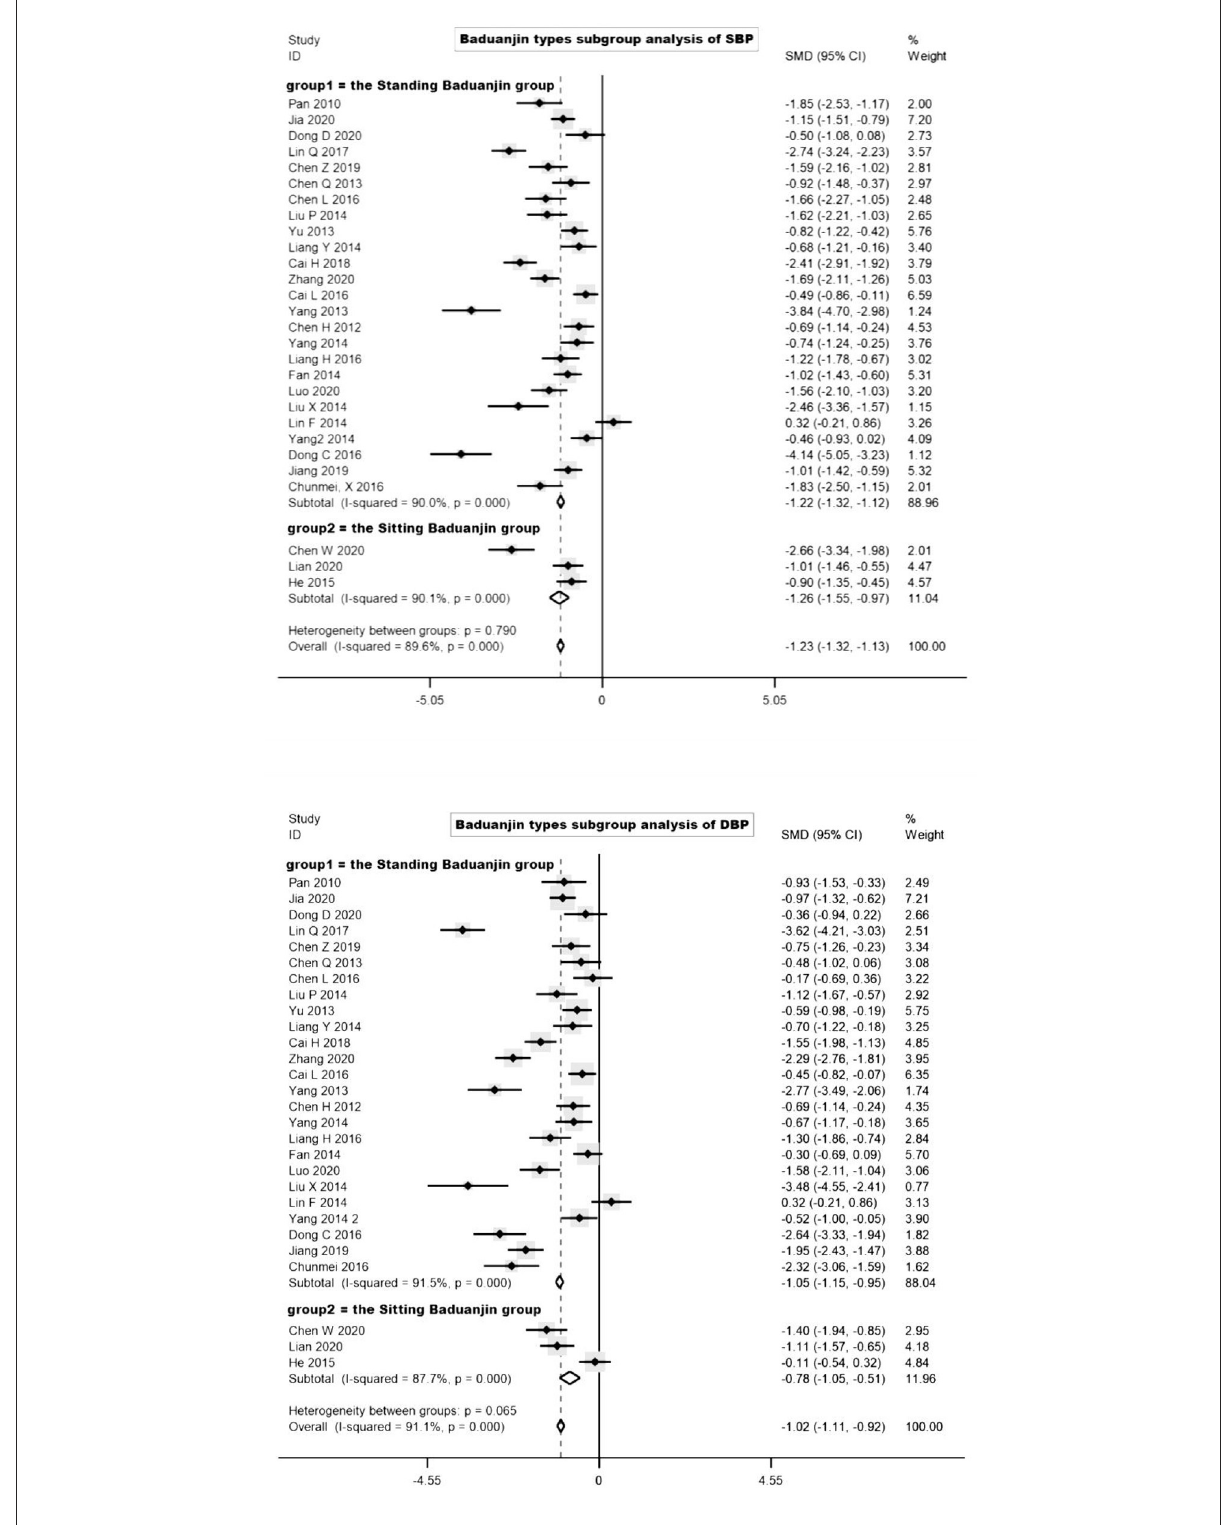
FIGURE4 Subgroup analysis of Baduanjin